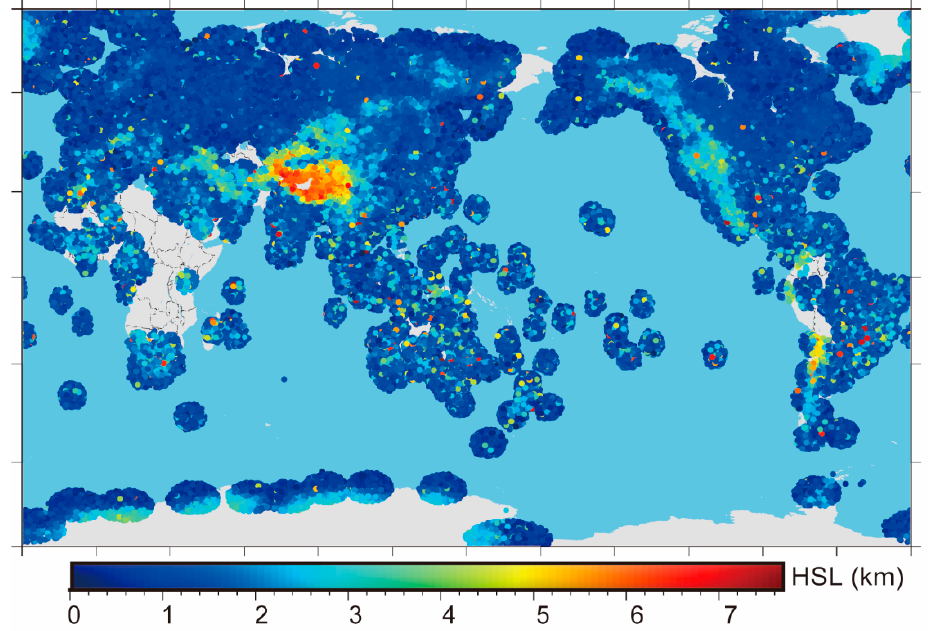
Figure 2. Bottom height distribution of sonPrf matched with atmPrf in 2008. The color indicates the lowest point of the common height of matched events in HSL.